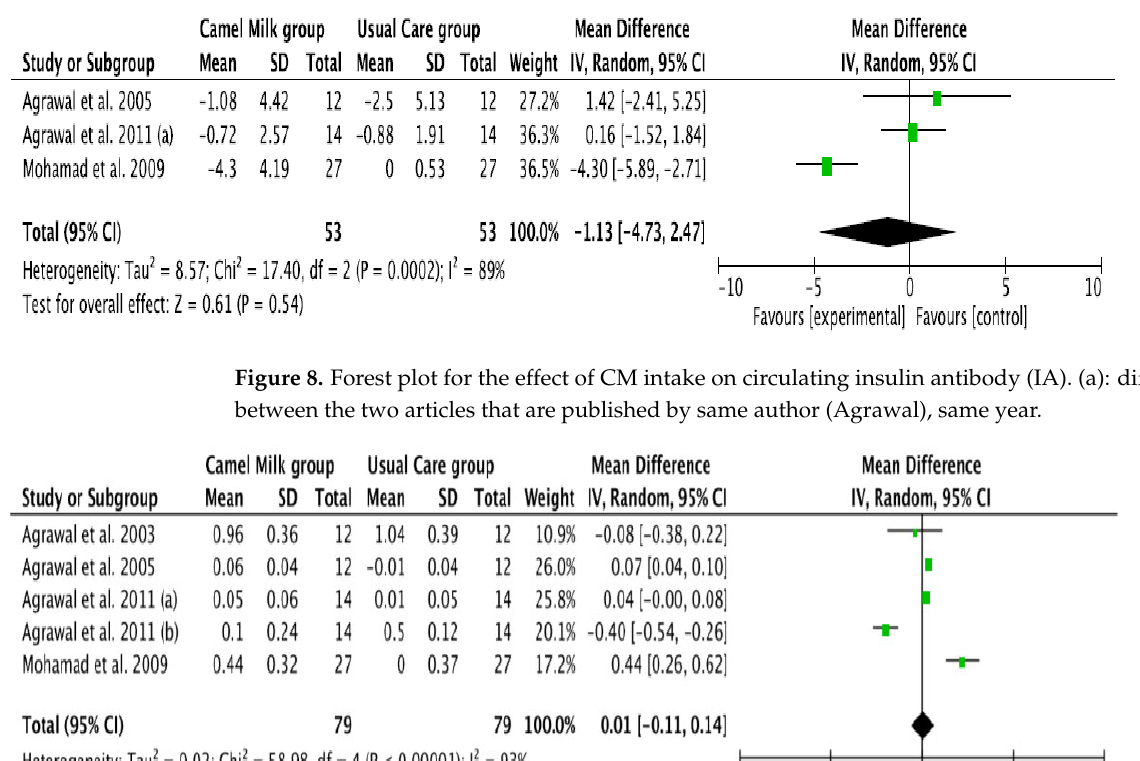
that are published by same author (Agrawal), same year.